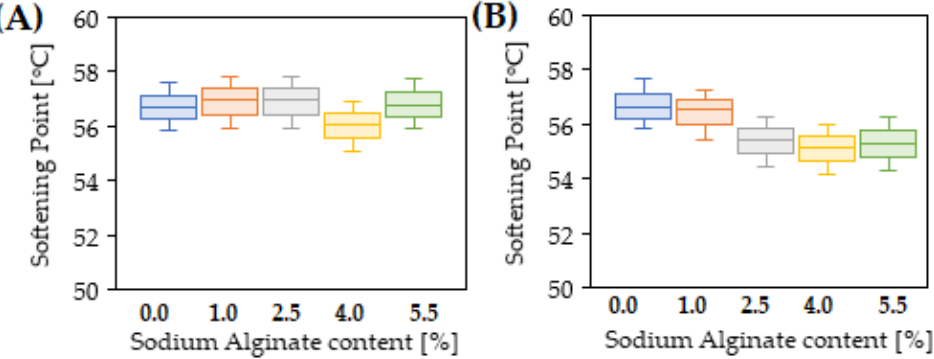
Figure 3. Softening point test results of 35/50 bitumen modified with sodium alginate ( A ) and 35/50 bitumen modified with sodium alginate in the presence of a crosslinking agent ( B ).